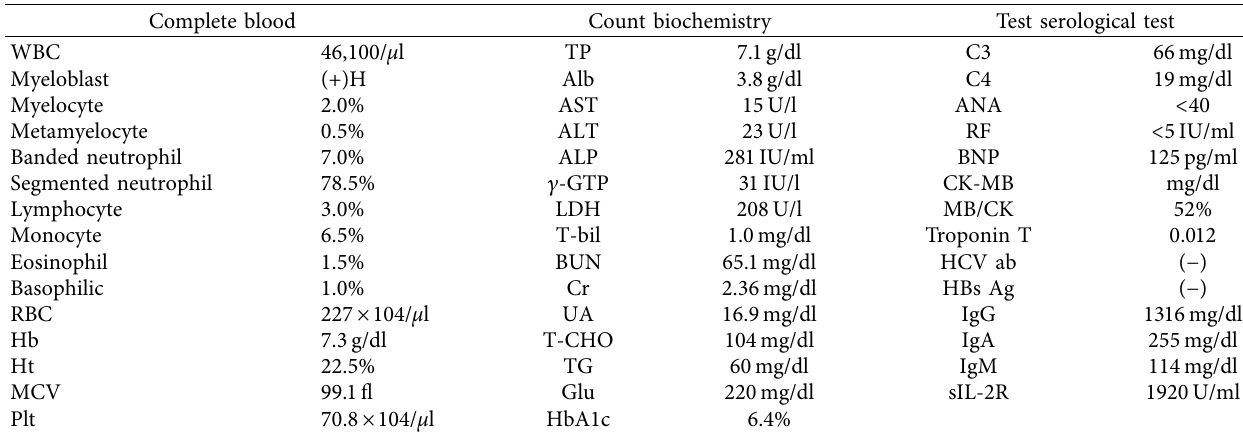
Figure 2: Imaging revealed heart enlargement, massive pericardial fluid, and a small amount of pleural fluid Table 1: Laboratory findings.